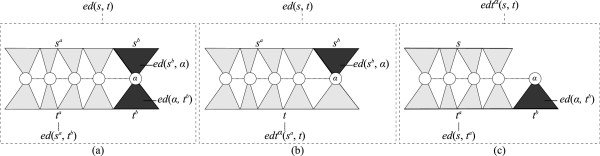
Edit distance computation when both input strings are of length at least 2. Chart (a) illustrates Equation 7, while charts (b) and (c) illustrate its decomposition into Equations 8 and 9, respectively.